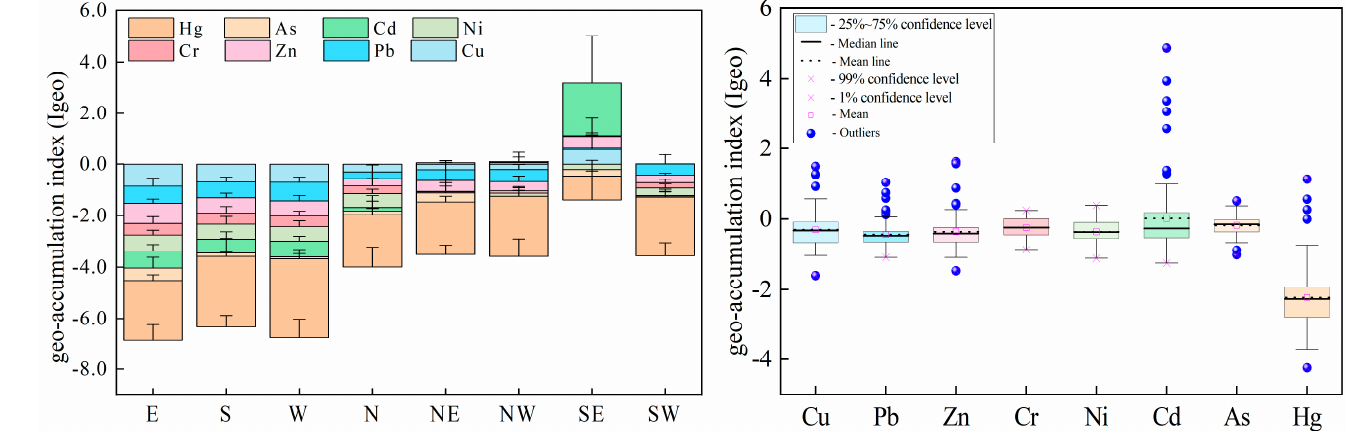
Figure 6. Characteristics of I geo risk values at landfill sites.